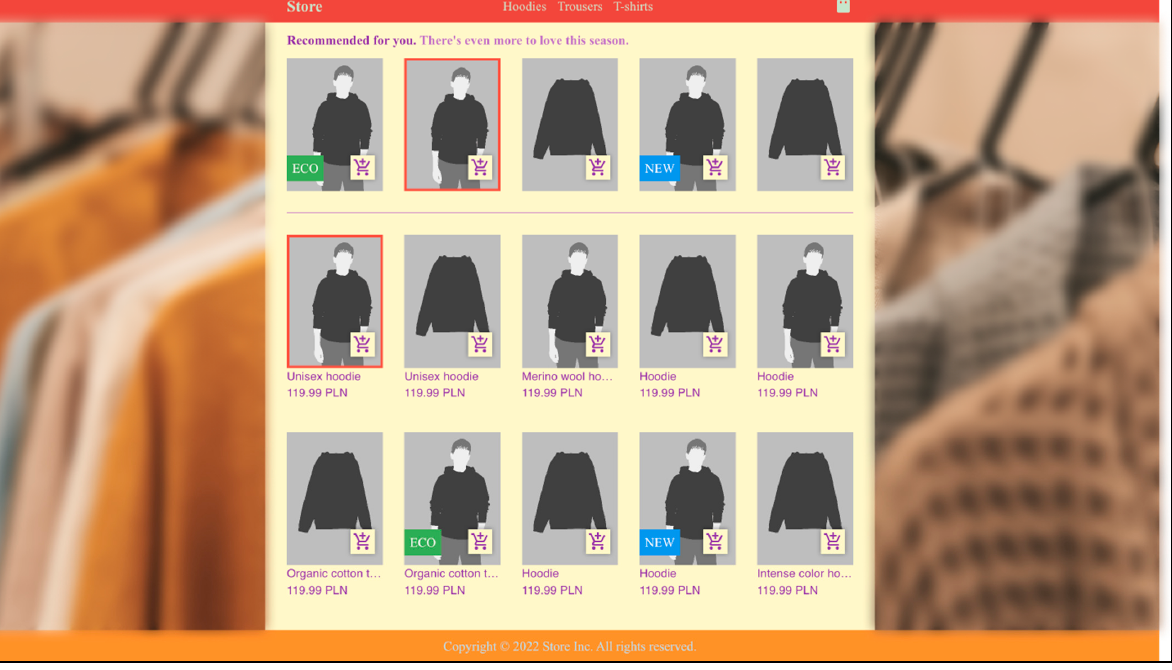
Figure 5. Unsightly store’s website appearance. Color palette: distinctive multi-color palette with a multi-colored image as the background. Product photos: height-to-width ratio 1.382, angular